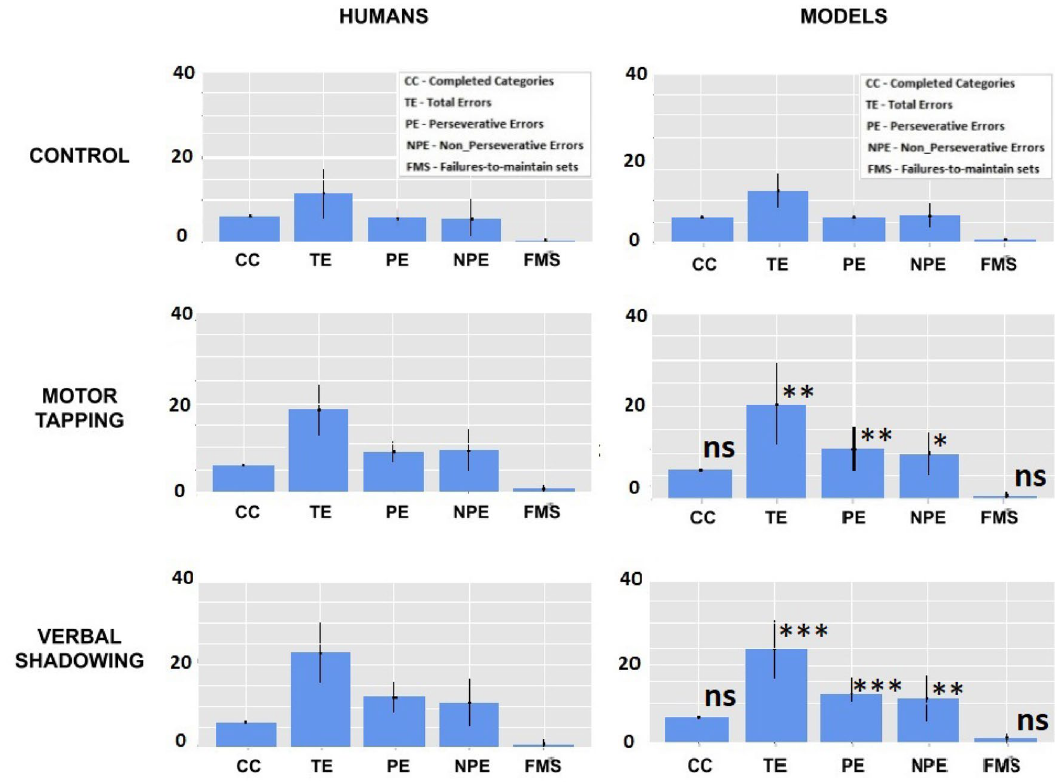
Figure 3. Comparison between human groups (left graphs) and models (right graphs) in the three conditions (rows of graphs) for each behavioural index. The significance asterisks in the model graphs are related to the comparison between each of the motor tapping and verbal shadowing models with the control model: ns = non statistically significant, p > 0.05 ; * = p < 0.05 ; ** = p < 0.01 ; *** = p < 0.001